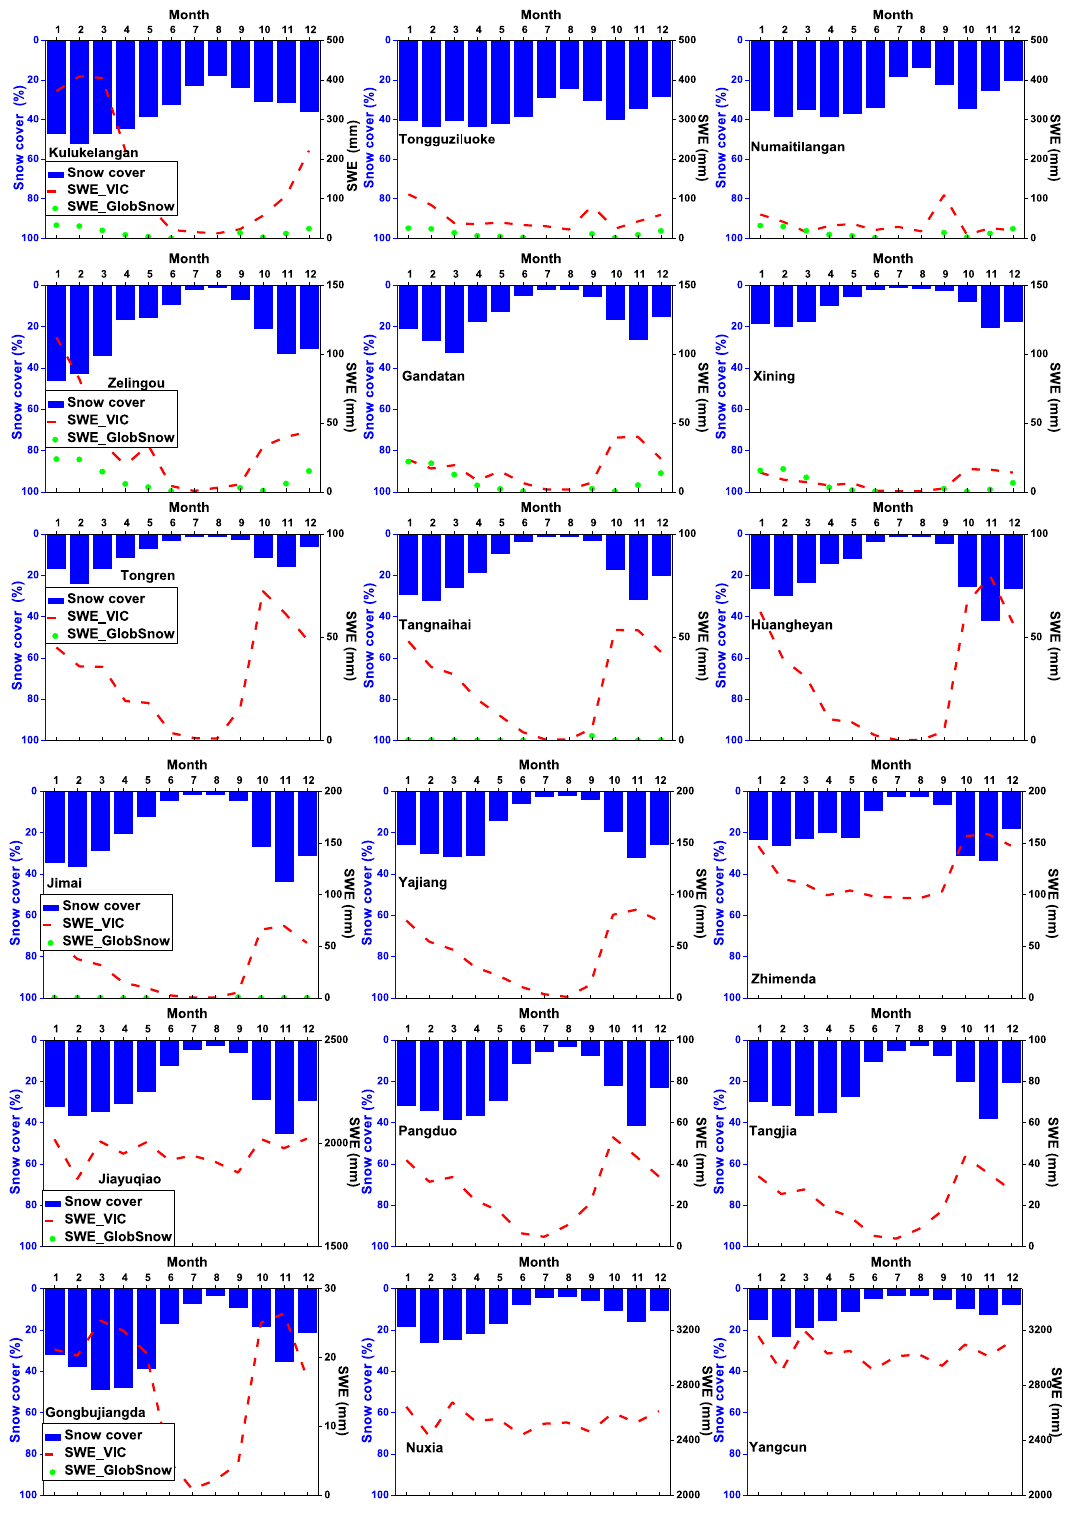
Figure 7. Seasonal cycles (1982–2011) of snow cover and snow water equivalent (SWE) in westerlies-dominated (row 1), east-Asian- monsoon-dominated (rows 2–4) and Indian-monsoon-dominated (rows 5–6) TP basins. The snow cover was extracted from a cloud-free snow composite product during the period 2005–2013. It should also be noted that the GlobSnow data are not available for some